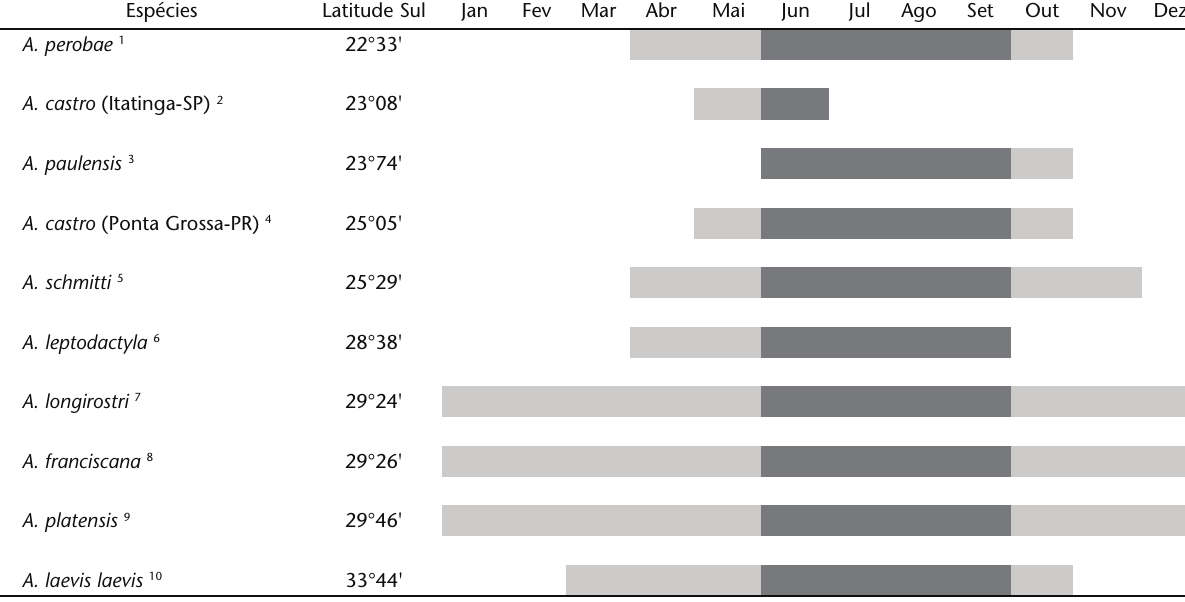
Tabela I. Períodos reprodutivos das diversas espécies de Aegla distribuídas em ordem crescente de latitude sul das respectivas áreas de estudo. A extensão das barras representa os meses de duração deste período. O destaque escuro indica os meses coincidentes de ocorrência de fêmeas